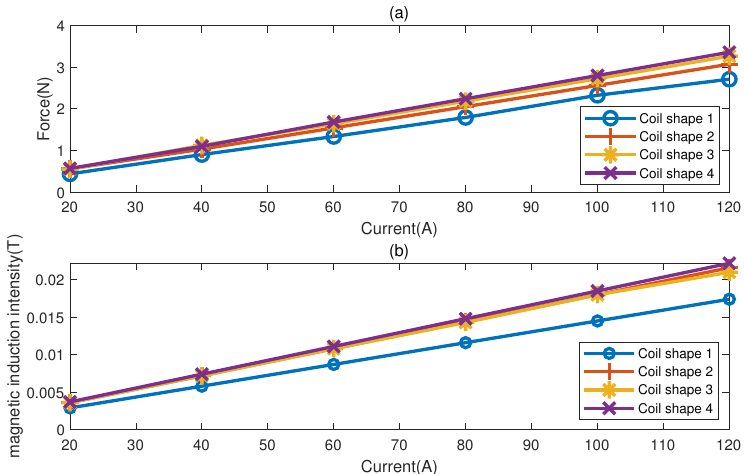
Figure 6. ( a ) The influence of coil shape on the relation curve between current and electromag- netic force. ( b ) The influence of coil shape on the relation curve between current and magnetic induction intensity.